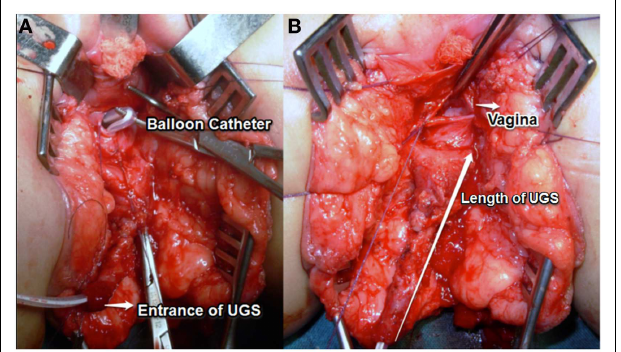
FIGURE 6 | (A,B) The vagina opened over the balloon, the foley catheter repositioned in the proximal urethra.The long arrow shows the length of the UGS.